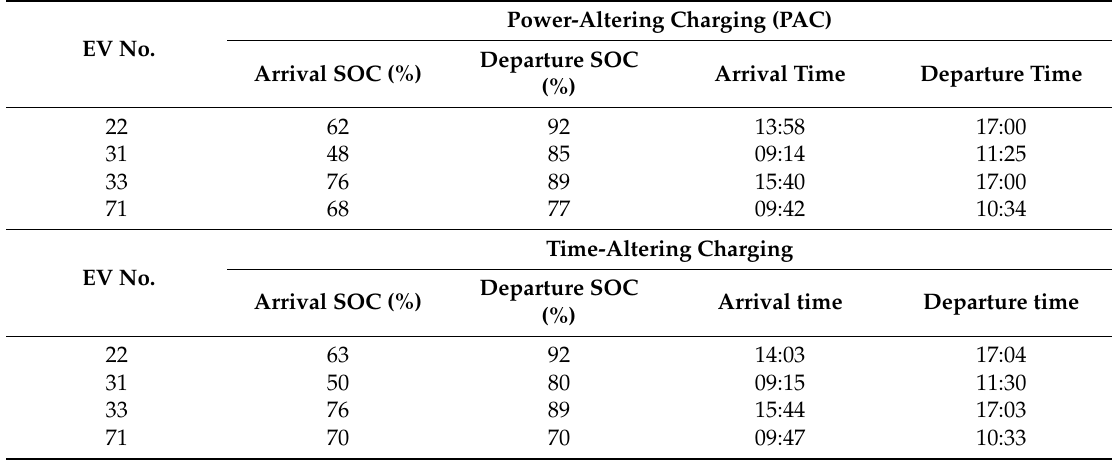
Table 3. Charging details of sample